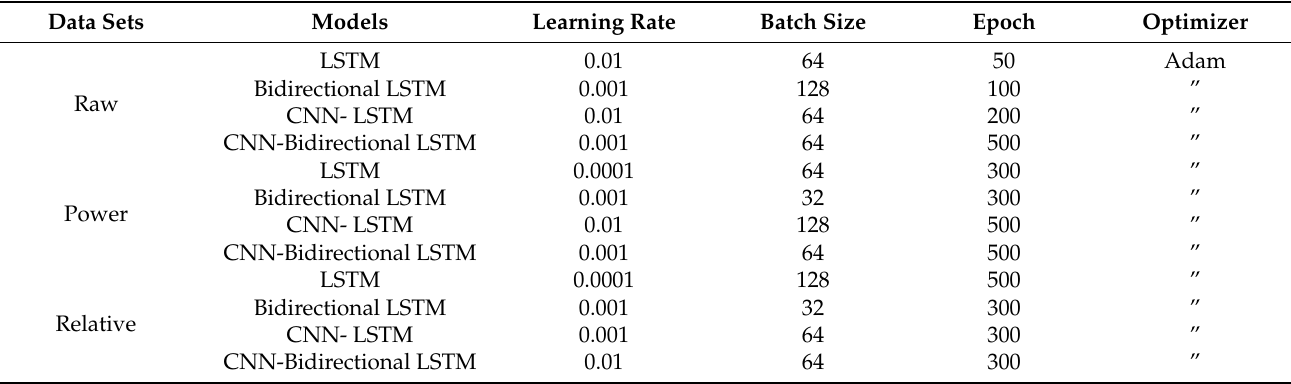
Table 9. Hyper-parameters of each